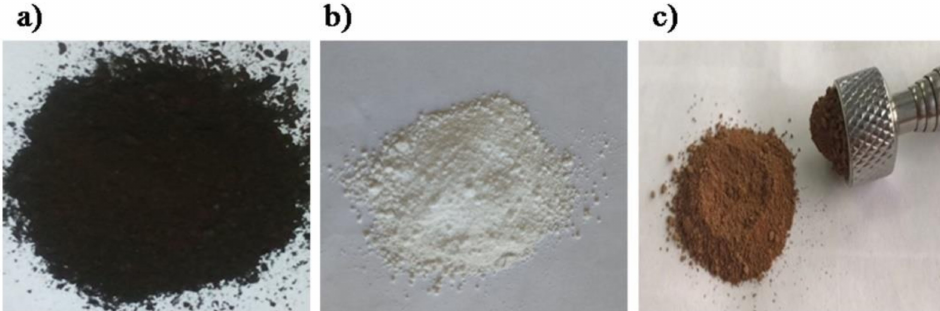
Figure 11. ( a ) Fe 3 O 4 nanoparticles ( b ) TiO 2 nanoparticles ( c ) TiO 2 –Fe 3 O 4